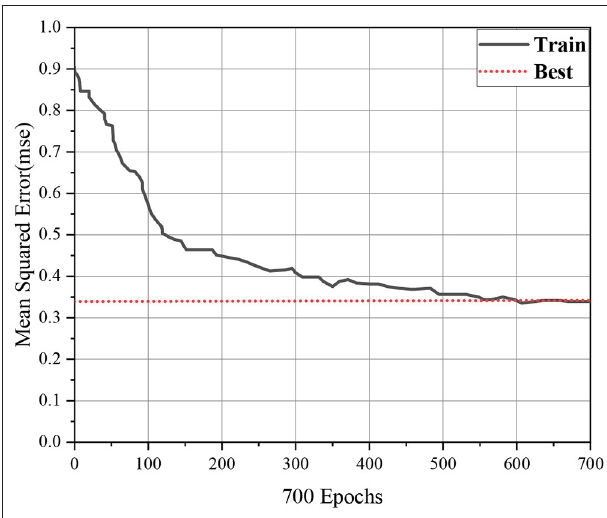
FIGURE 8 | The convergence diagram of the target error of the BPNN.